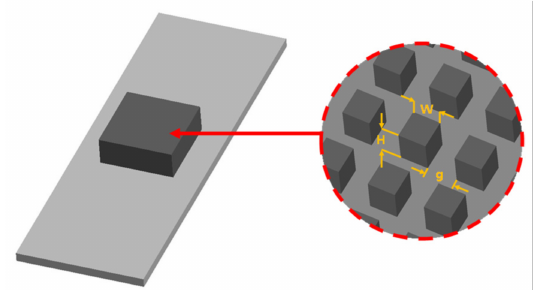
Figure 1. Structure of the copper micro-pin fin